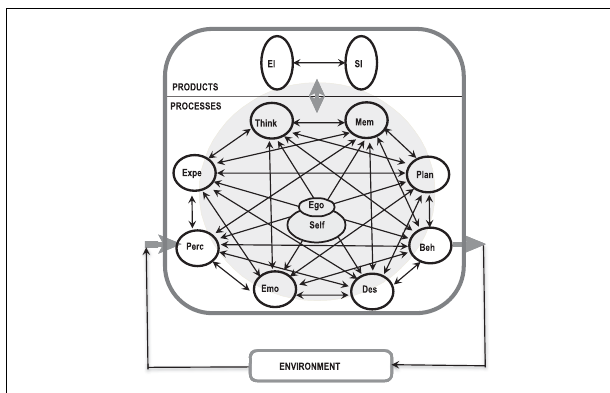
FIGURE 15 | The list of mental operators (subsystems) as an operationally closed network. Consciousness is represented here as a shaded circle, regarding the metaphor of light and dark. Not all relations – especially of the ego/self – are depicted here. Perc, perception; Expe, expectation; Thin, thinking; Mem, memory; Plan, plans of behavior; Beh, behavior; Des, desires; Emo, Emotions; EI, environmental image; SI, self-image as affective-cognitive